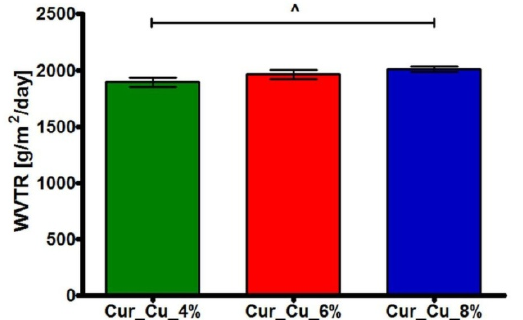
Figure 3. The ability of Cur_Cu_4%, Cur_Cu_6%, and Cur_Cu_8% samples to transmit water vapor during 24-h experiment. ^—significantly different results between Cur_Cu_4% and Cur_Cu_8%; one-way ANOVA followed by Tukey’s multiple comparison test, p < 0.05.